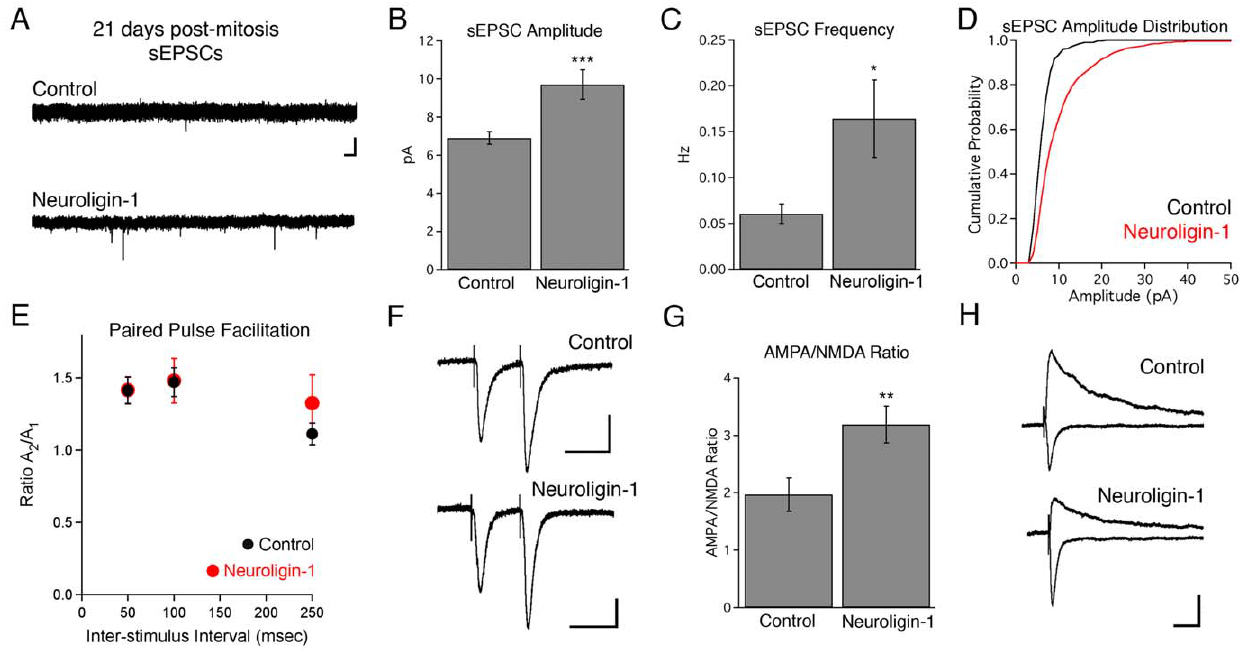
Figure 4. Neuroligin-1 overexpression increases the amplitude and frequency of spontaneous excitatory post-synaptic currents in 3-week-old granule cells. A. Representative sEPSC recordings from control (GFP only) and neuroligin-1 IRES GFP infected 21-day-old neurons in the absence of TTX. Scale bars: 10 pA, 500 ms. B, C. Summary data for sEPSC amplitude and frequency in 21-day-old adult-born neurons (n=13 cells in each group, data shown 6 SEM; * p , 0.05, *** p , 0.005). D. sEPSC amplitude distributions skew toward larger event amplitudes in neuroligin-1 overexpressing cells (p , 0.0005, K-S test). E. Paired pulse facilitation is not altered in 21-day-old neuroligin-1 overexpressing cells relative to control (GFP only) cells. PPF is represented as the ratio of the peak amplitude of the second current to that of the first (control, n=13,4,4 cells; NLG-1, n=18,6,6 for 50, 100, and 250 ms intervals respectively; p . 0.2 all groups). F. Representative traces at a 50 ms interval are shown for control and neuroligin-1 overexpressing 21-day-old neurons. Scale bars: 10 pA (Control), 20 pA (Neuroligin-1), 50 ms (both). G. Neuroligin-1 overexpression increases the ratio of AMPAR-mediated currents relative to NMDAR-mediated currents in 21-day-old granule cells (shown 6 SEM; control, n=16 cells; NLG-1, n=12 cells; ** p , 0.01). H. Sample recordings showing AMPAR-mediated currents (downward deflections) and slower combined